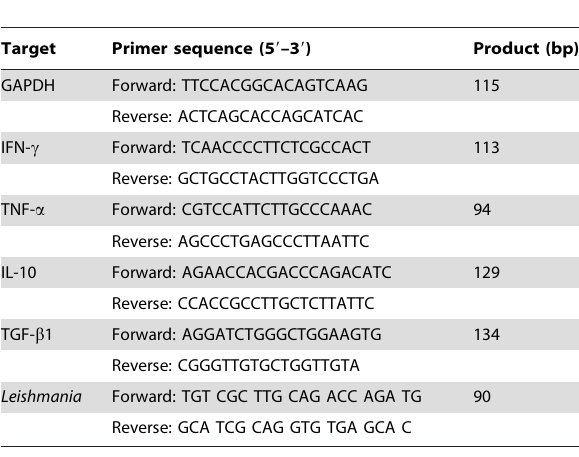
Table 1. Sequences of primers used for real-time